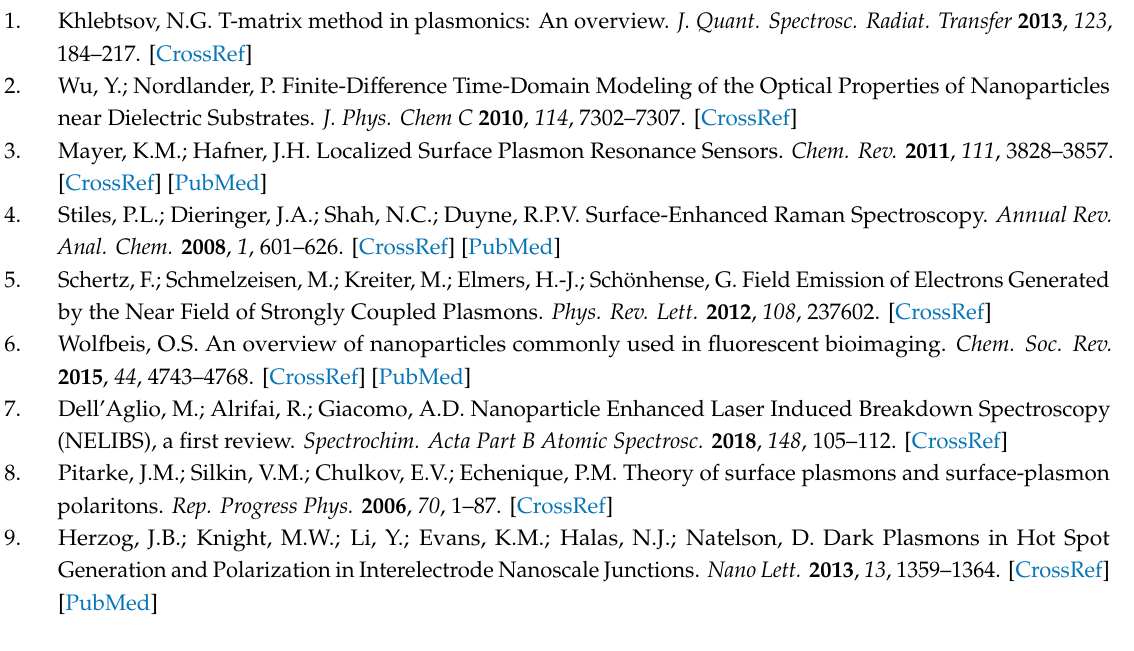
Figure S1: Examples of secular determinant of various NPs system